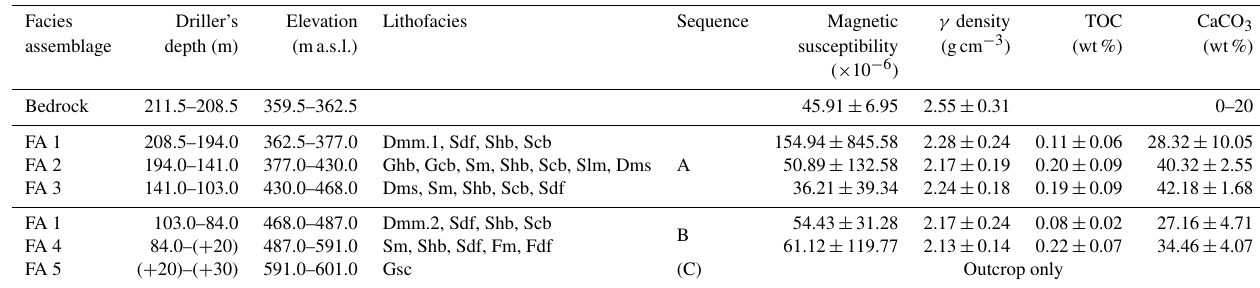
Table 2. This is a summary of the identified lithofacies assemblages, their extent from the top of the drilling, their extent in absolute elevation (surface 571ma.s.l.), and the different lithofacies they comprise. The table also shows how the facies assemblages are grouped into the major sequences. Along with the assemblages, the mean values of the measured γ density, TOC content, and CaCO 3 concentration are presented. The CaCO 3 concentration of the bedrock is based on Blaser et al. (1994).